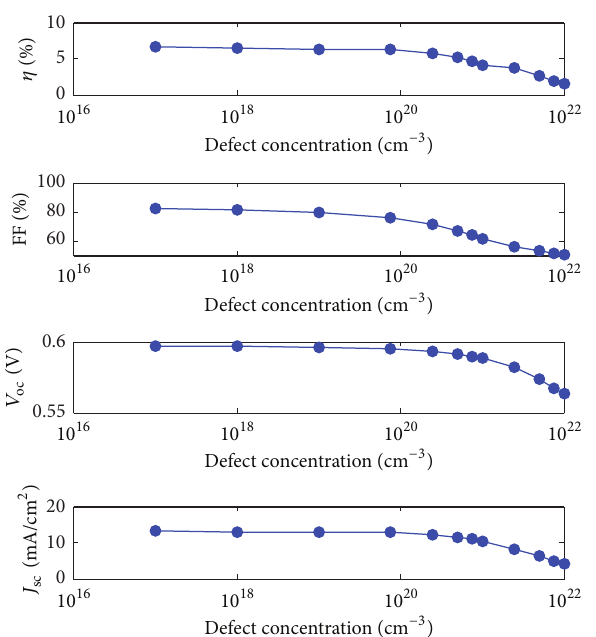
Figure 8: The impact of discrete defect concentration in the middle of the SWCNT layer band gap on the electrical